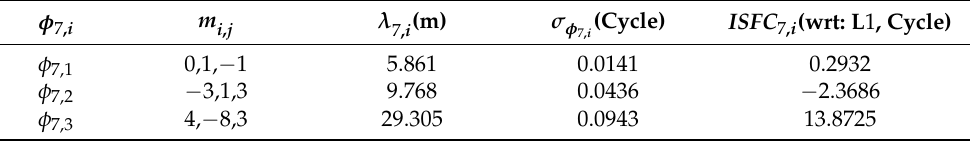
Table 1. The optimized phase combinations of triple-frequency global position system (GPS).